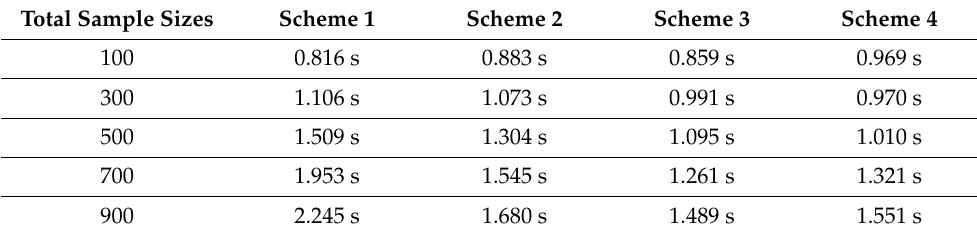
Table 2. The performing time on the Chipwhisperer MCU platform.